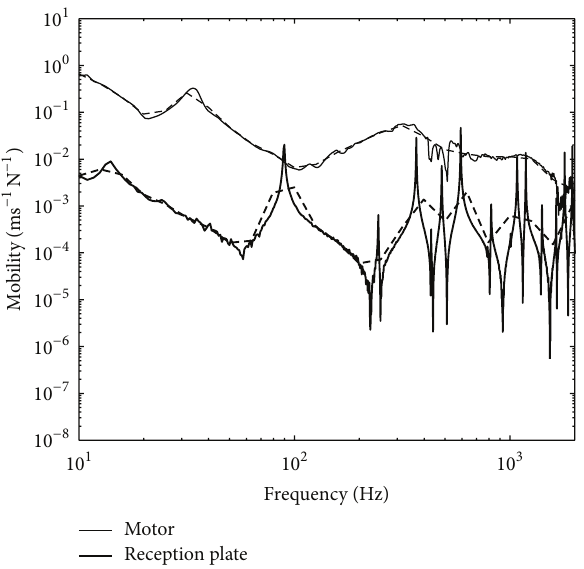
Figure 11: Comparison of measured average mobility from the low mobility reception plate and the fan motor: narrow band (solid-line) and one-third octave band (dashed-line).